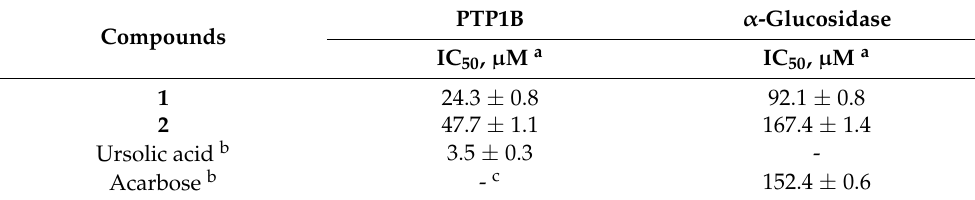
Table 1. PTP1B and α -glucosidase inhibitory activities of compounds ( 1 - 2 ) isolated from T. ruticarpum .